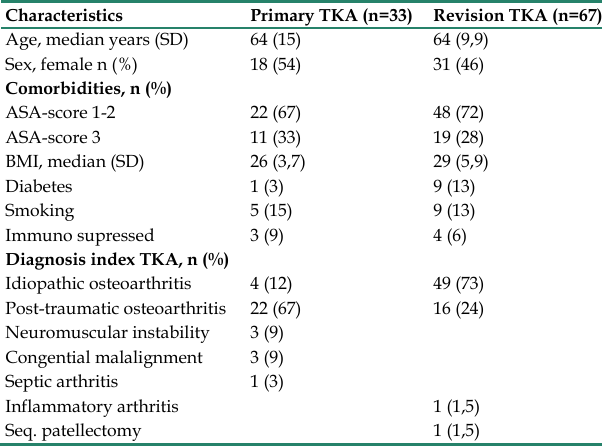
Table 1. Preoperative patient characteristics in 100 constrained and hinged condylar TKAs